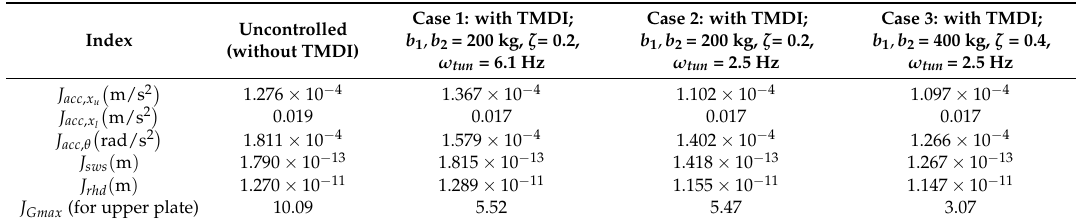
Table 4. The result of the numerical solution of the isolation system; representation of the indices for different cases.